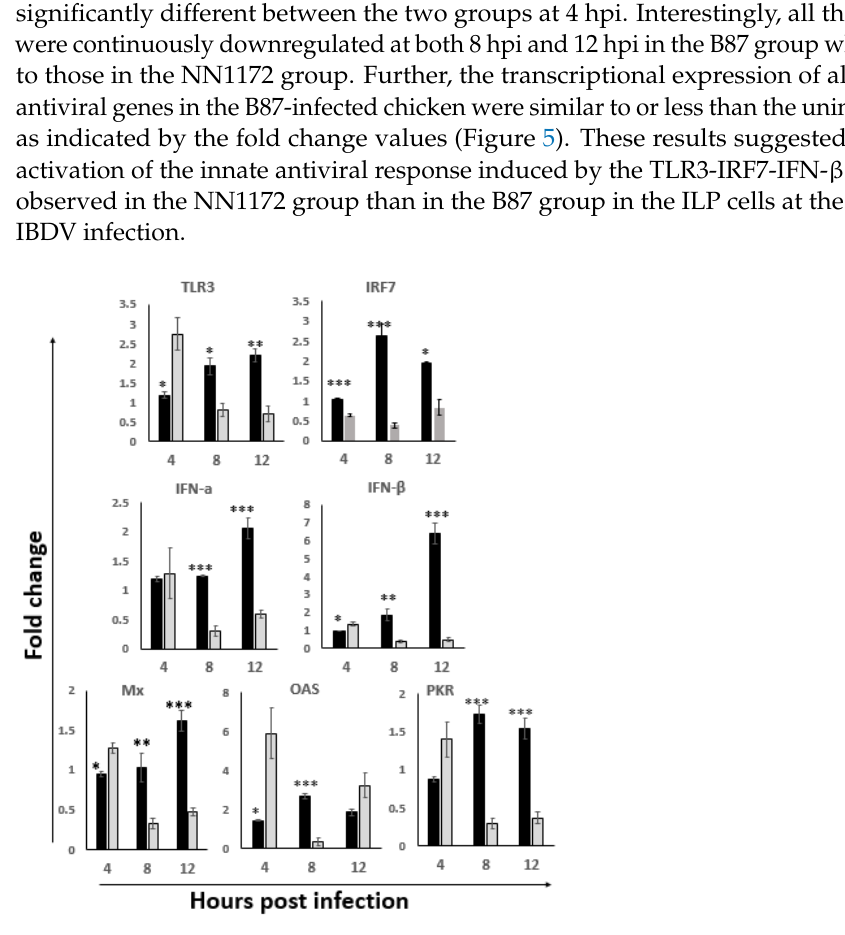
Figure 5. Differential modulation of TLR3 antiviral pathway in the ILP cells at the early stage of infection with IBDVs of different virulence. The mRNA expression levels of antiviral pathway genes in the ILP cells of IBDV infection were detected at 4 hpi, 8 hpi and 12 hpi. All the data were normalized to uninfected control. Results represent mean ± SEM, n = 5. (* p < 0.05; ** p < 0.01; *** p < 0.001) between the HLJ0504-like vvIBDV infected group (black bar) and the attenuated B87 infected group (gray bar).